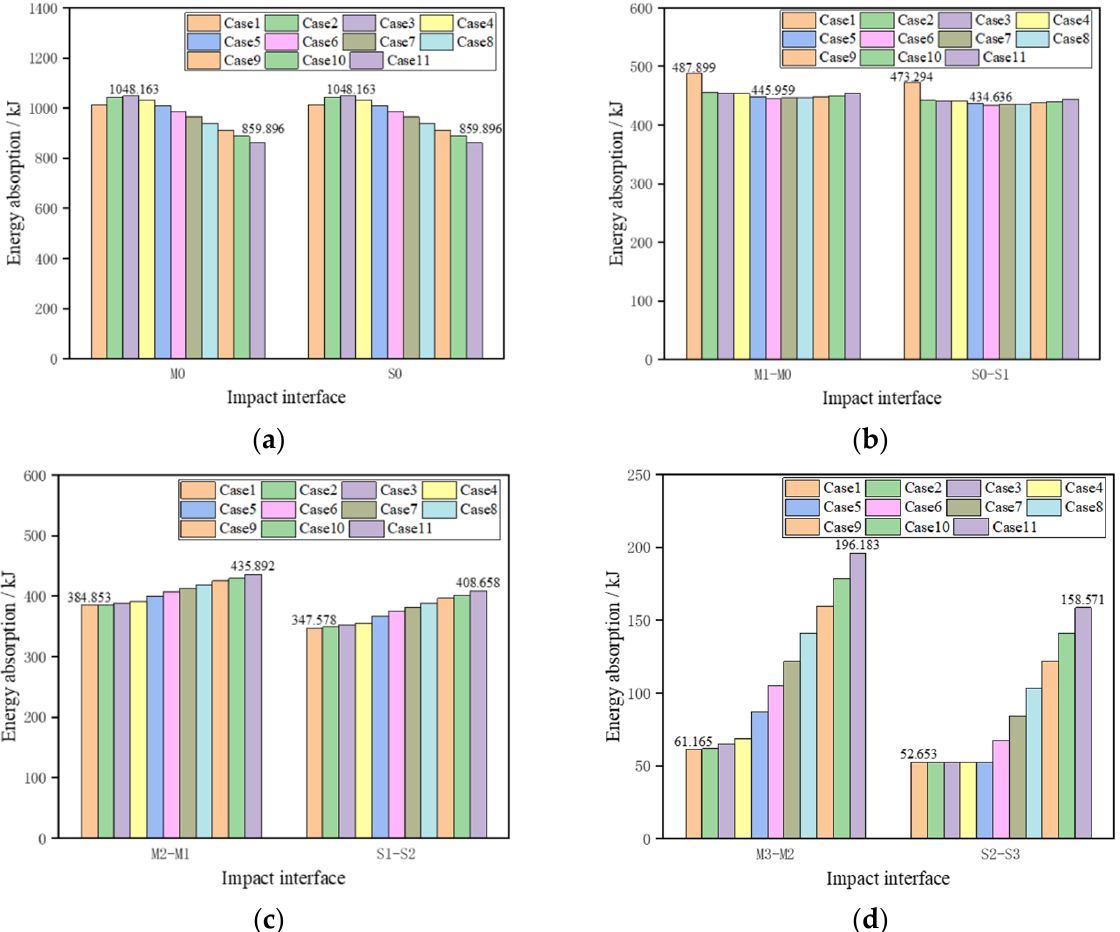
Figure 13. Influence of the platform force change on specific impact interfaces: ( a ) the head cars: M0 and S0; ( b ) the first middle car interfaces; ( c ) the second middle car interfaces; ( d ) the third middle car interfaces.